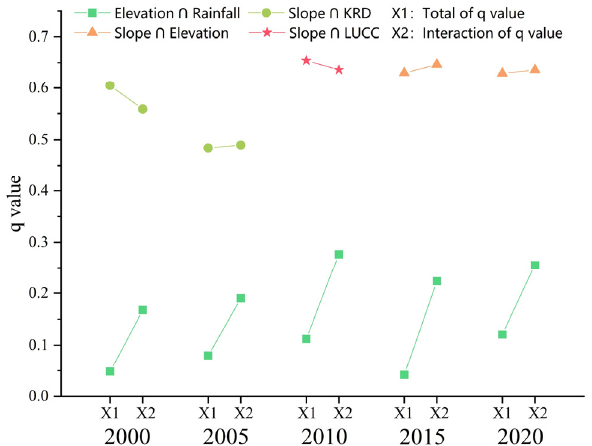
Figure 9. Factor interaction variation. X1 is the sum of the two-factor q values. X2 is the q value of the interaction of the two-factor.